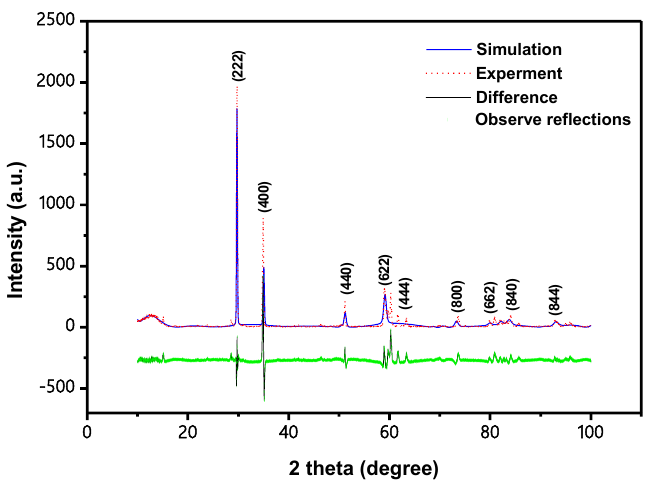
Figure 1. XRD pattern and Rietveld refinement of In 2 YSbO 7 (red dotted line represents experimental XRD data for In 2 YSbO 7 ; blue solid line represents simulated XRD data for In 2 YSbO 7 ; black solid line represents the difference between experimental and simulated XRD data for In 2 YSbO 7 ; green vertical lines indicate the observed reflection locations). Table 1. Structural parameters of In 2 YSbO 7 synthesized by solvothermal